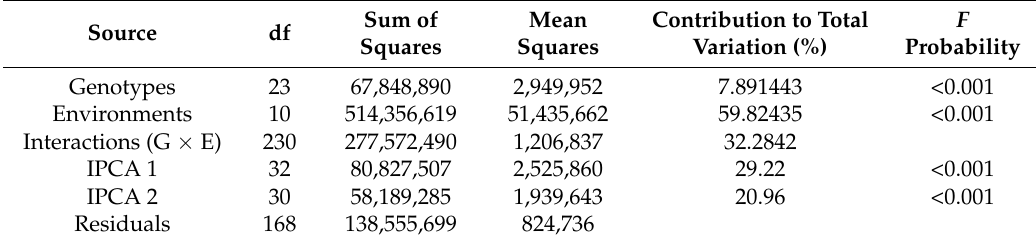
Table 6. Analysis of variance for additive main effects and multiplicative interaction model for grain yield of 24 hybrids across 11 environments.